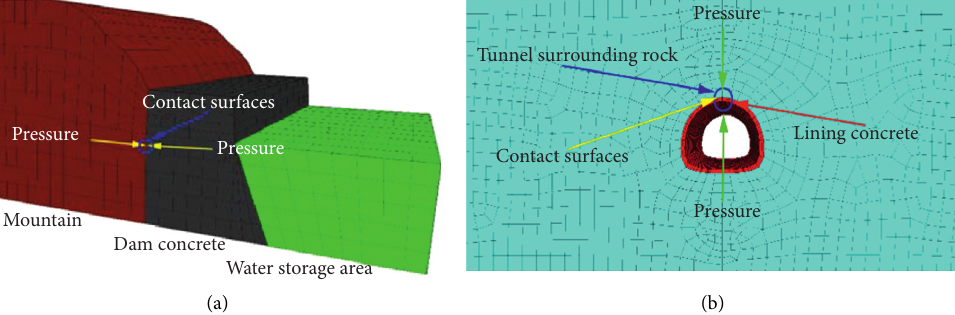
Figure 1: Schematic diagram of rock-concrete composite structure in actual engineering. (a) Dam bedrock-concrete structure. (b) Tunnel confining-lining concrete